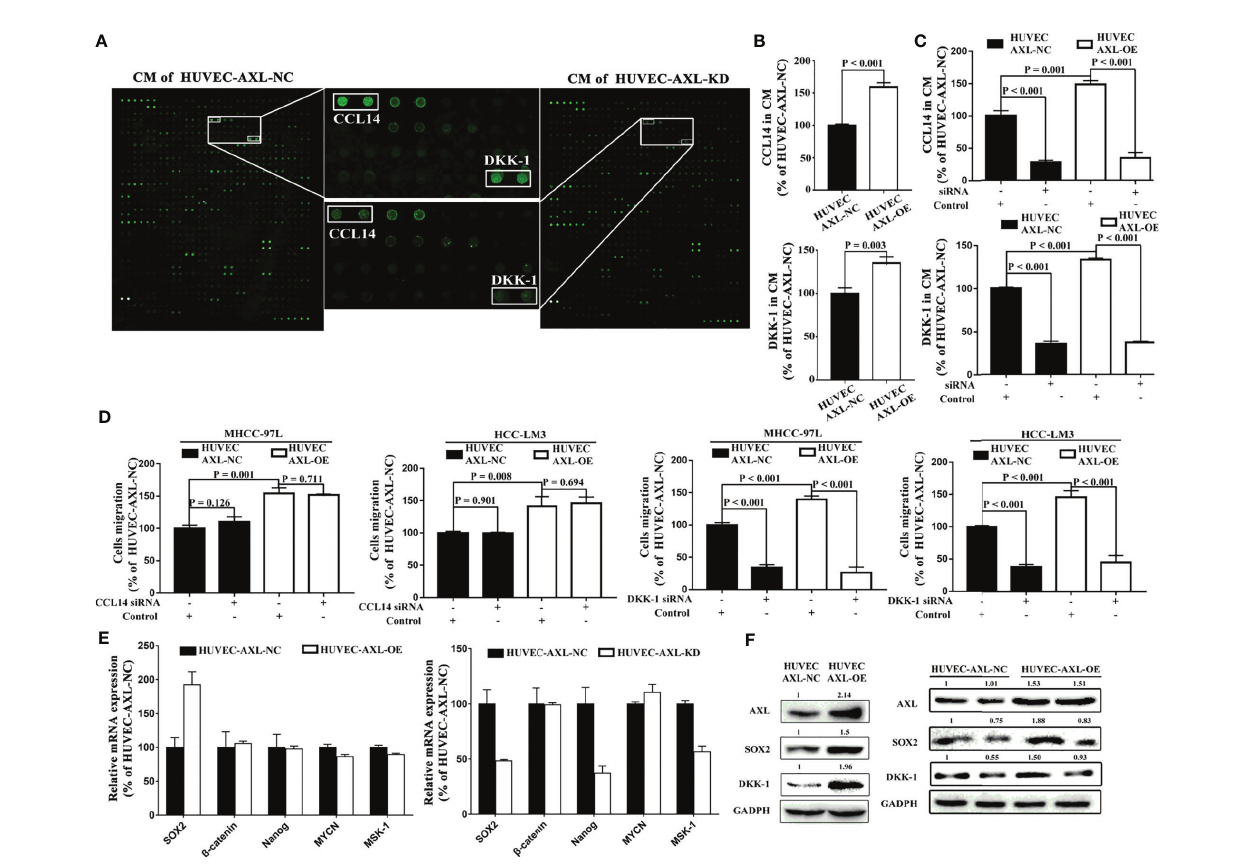
FIGURE 5 | AXL/SOX2/DKK-1 axis in HUVECs promotes HCC metastasis. (A) DKK-1 and CCL14 secretion was signi fi cantly downregulated in CM from HUVEC- AXL-KD compared with that from HUVEC-AXL-NC, as detected with a human cytokine antibody array. (B) DKK-1 and CCL14 expression was markedly upregulated in the CM of HUVECs overexpressing AXL (CCL14: p < 0.001; DKK-1: p = 0.003) compared with the CM of HUVEC-AXL-NC, as detected by ELISA assay. (C) AXL siRNA downregulated DKK-1 and CCL14 secretion in the CM of HUVEC-AXL-NC and HUVEC-AXL-OE cells (CCL14: p < 0.001 and p < 0.001; DKK-1: p < 0.001 and p < 0.001). (D) DKK1 siRNA (MHCC-97L: p < 0.001 and p < 0.001; HCC-LM3: p <0.001 and p < 0.001), but not CCL14 siRNA (MHCC-97L: p = 0.126 and p = 0.711; HCC-LM3: p = 0.901 and p = 0.694) could attenuate the effect of the CM from HUVEC-AXL-NC and HUVEC-AXL-OE cells on the migration of HCC-LM3 cells and MHCC-97L cells. (E) SOX2 mRNA expression was signi fi cantly increased in HUVEC-AXL-OE cells and decreased in HUVEC-AXL-KD cells compared with HUVEC-AXL-NC cells (HUVEC-AXL-KD: p < 0.001, HUVEC-AXL-OE: p < 0.001). (F) AXL overexpression could signi fi cantly increase SOX2 and DKK-1 protein expression in HUVEC-AXL-OE cells compared with HUVEC-AXL-NC cells, and SOX2 siRNA inhibited SOX2 and DKK-1 protein expression in HUVEC-AXL-OE and HUVEC-AXL-NC